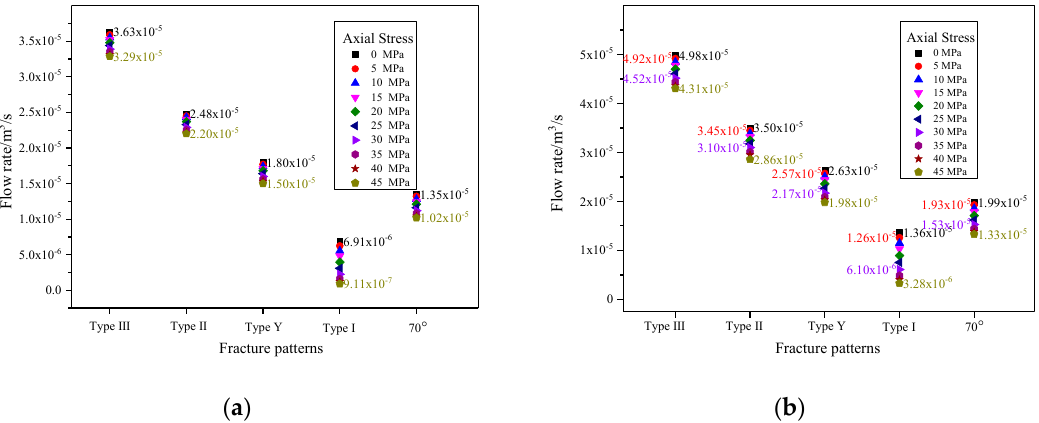
Figure 30. Flow rate change curves of different crack modes: ( a ) confining pressure of 20 MPa and ( b ) confining pressure of 10 MPa.